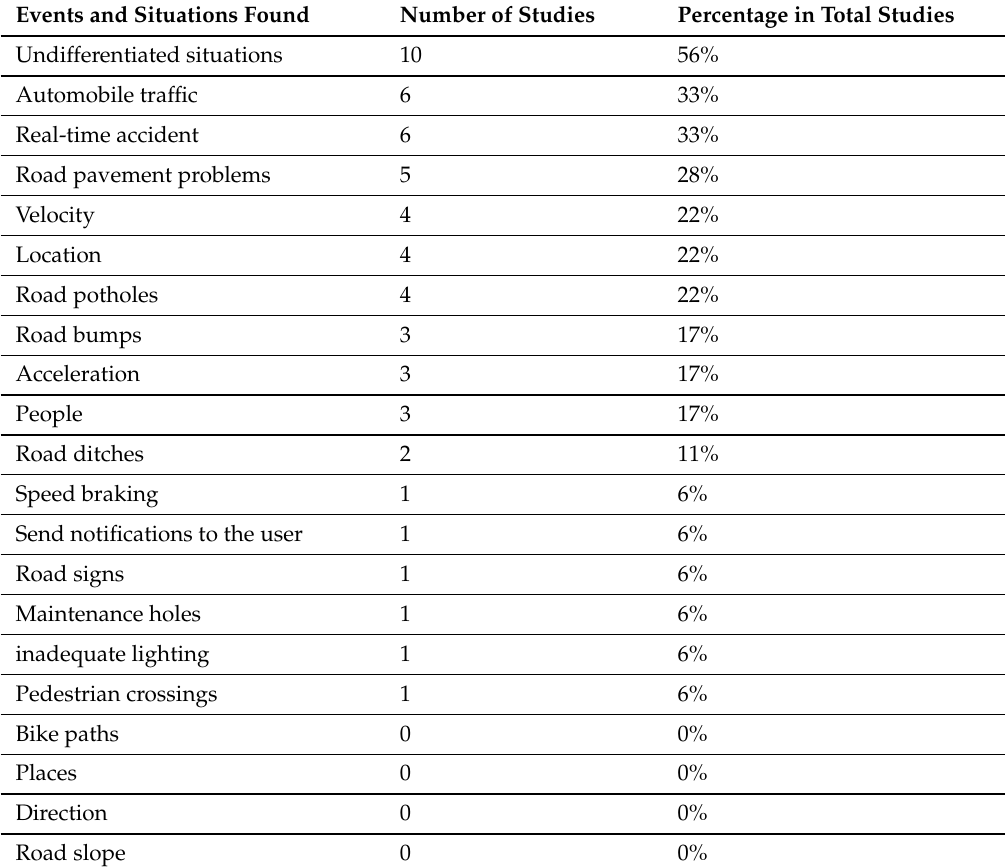
Table 1. Analysis of the number of studies with different